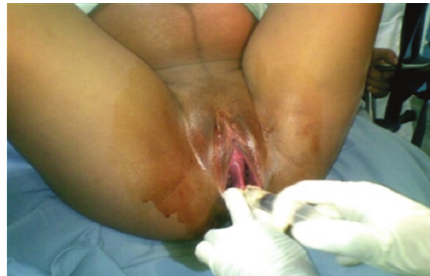
Figure 2: Anesthetic injection into the septum.